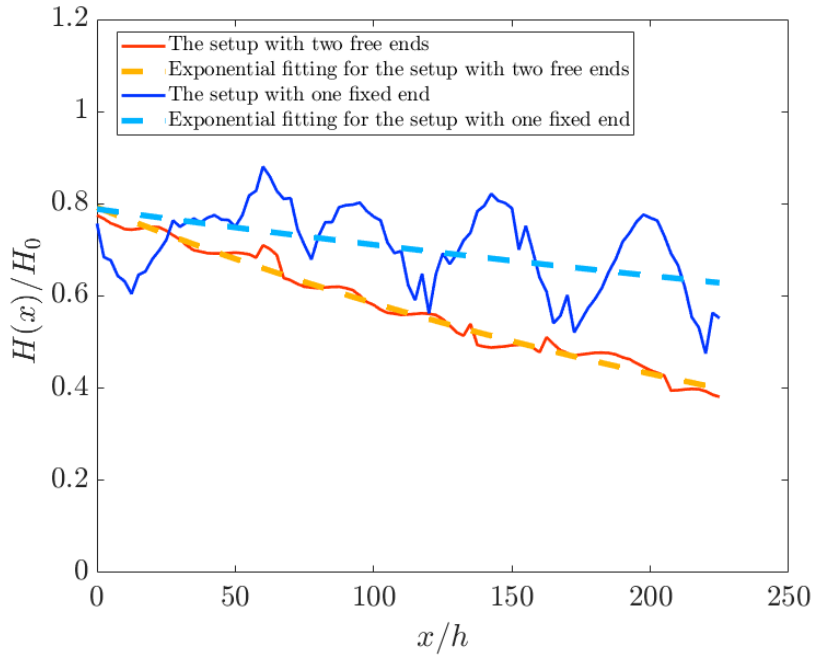
Figure 6. Reduction in the wave motion along the viscoelastic cover exposed to water waves. The red and the blue curves show the data found by free – free and free – fixed conditions assumed for the solid body.